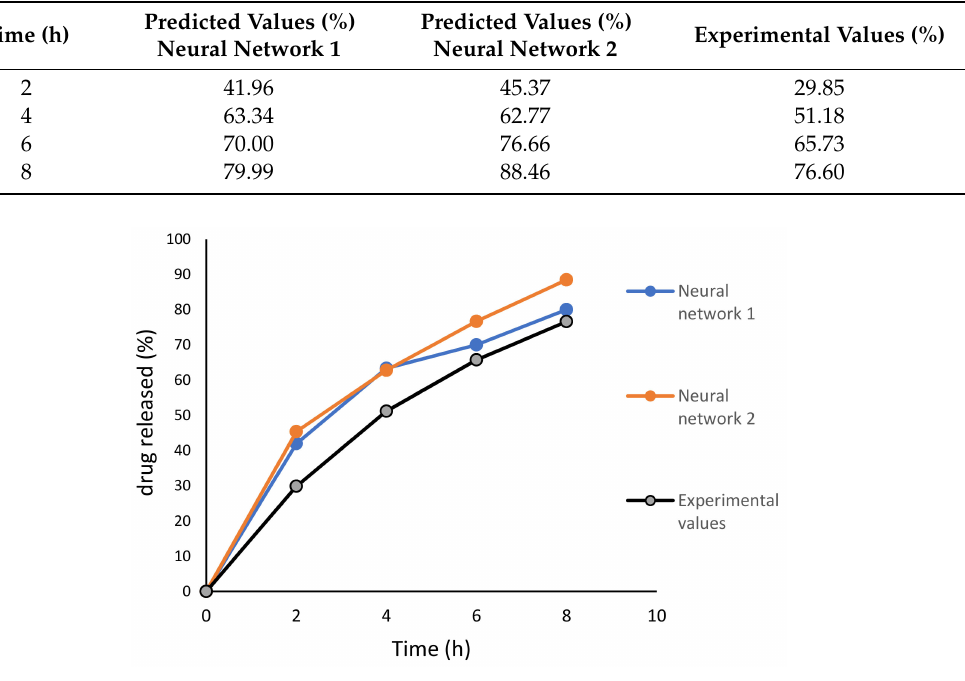
Figure 10. Experimental and predicted dissolution test